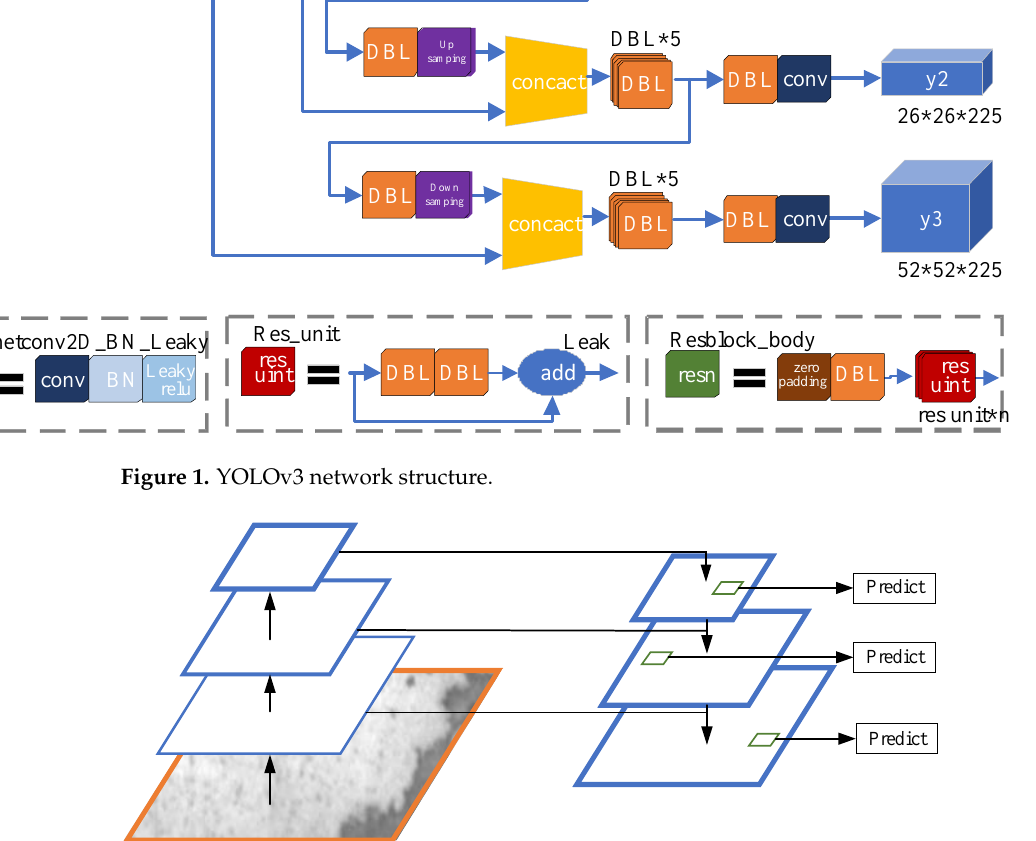
Figure 1. YOLOv3 network structure.